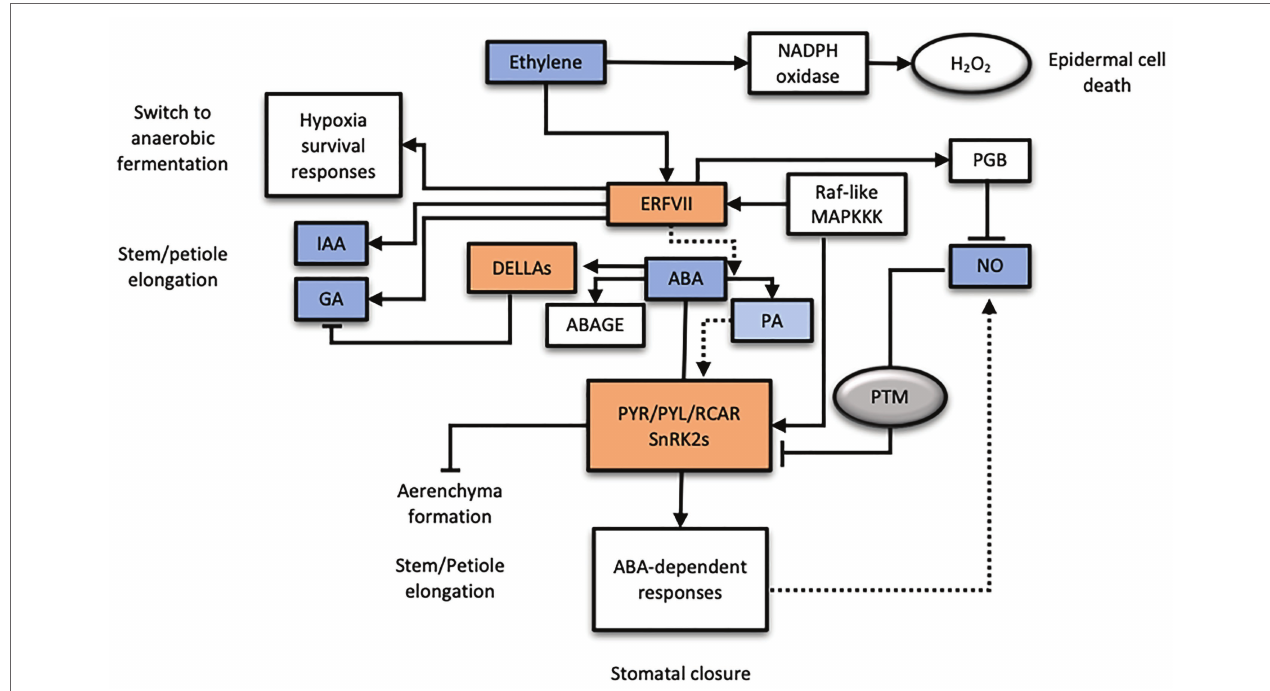
FIGURE 2 | Working model of the ABA hormone under low oxygen conditions and its interaction with other plant hormones. Plant hormones involved are indicated in blue color, whereas molecular key players of different hormone signaling pathways are highlighted in orange color. PTM, protein post-translational